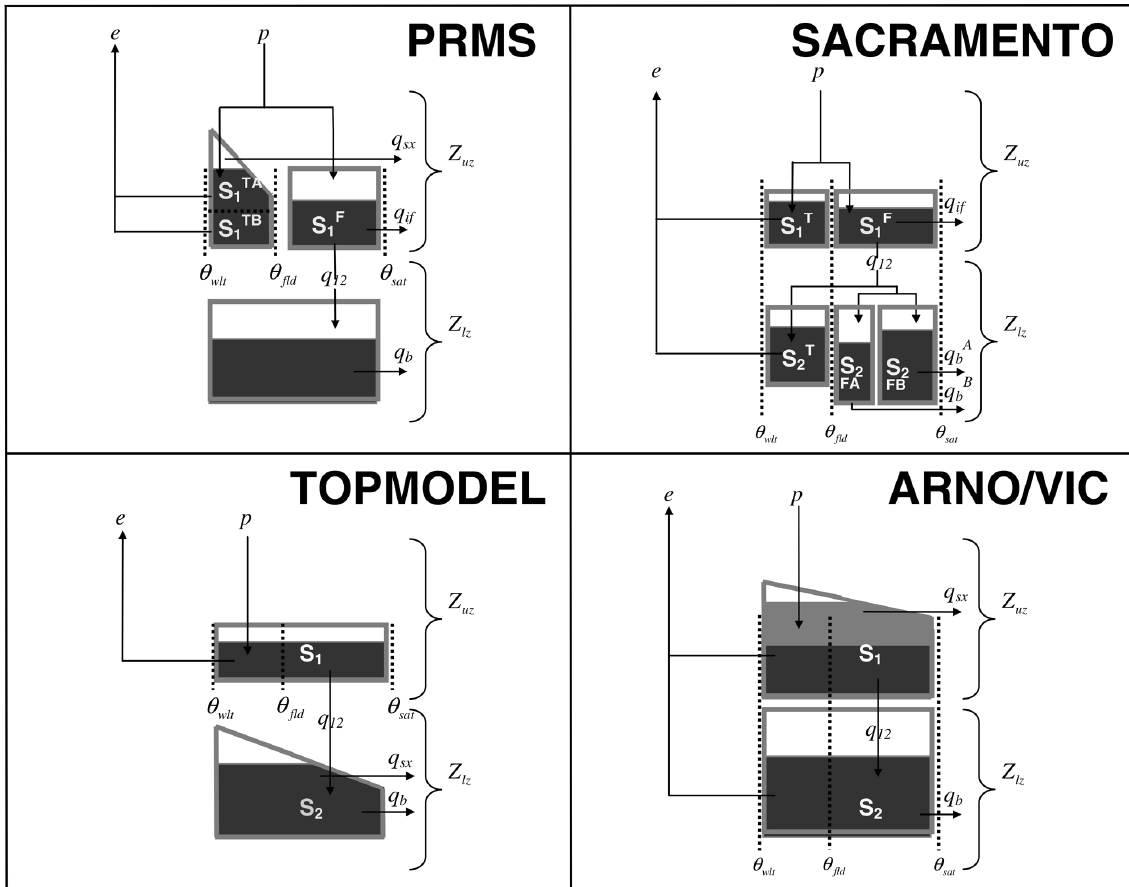
Fig. 2. Simplified wiring diagrams of the parent models (modified after Clark et al.,